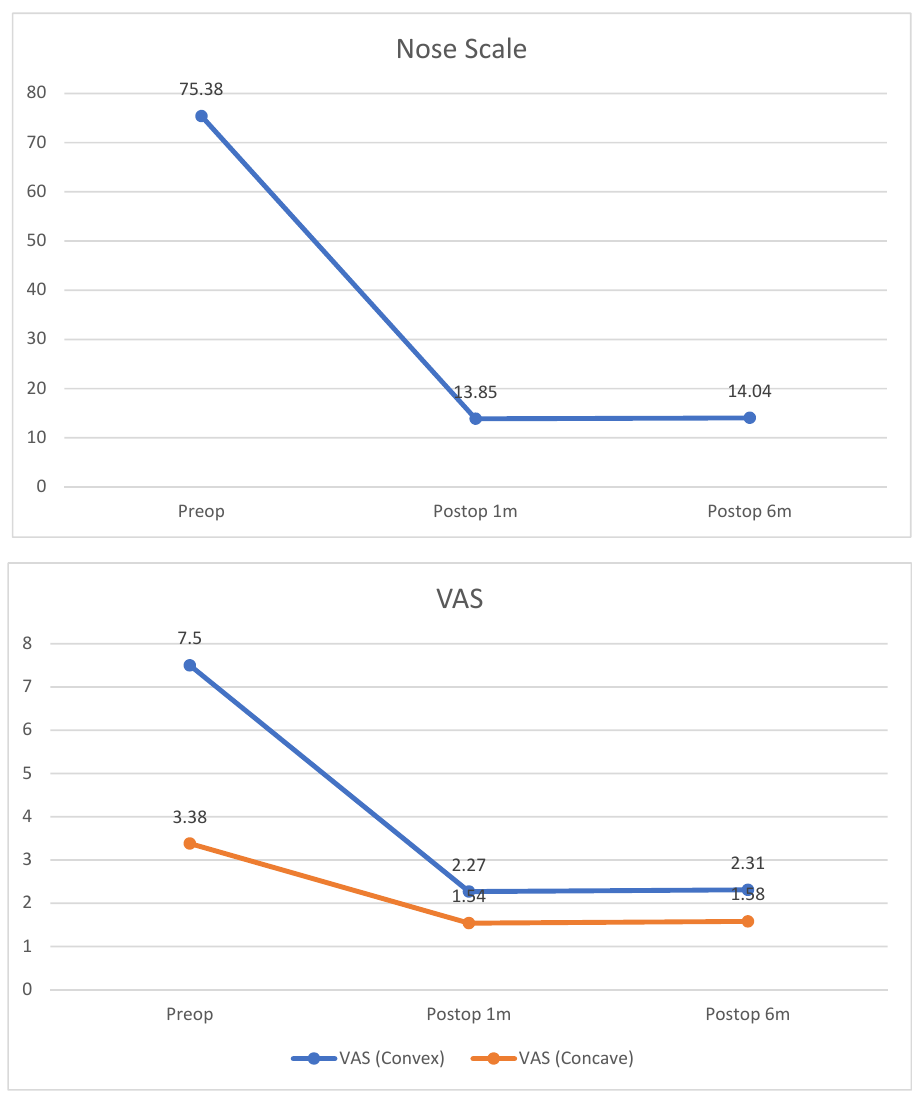
Figure 4. Nasal obstruction symptom evaluation (NOSE) scale and visual analog scale (VAS) improve- ment after performing endonasal functional rhinoplasty using an autologous septal cartilaginous batten graft. Abbreviations: NOSE, nasal obstruction symptom evaluation; VAS, visual analog scale; 1m, 1 month; 6m, 6